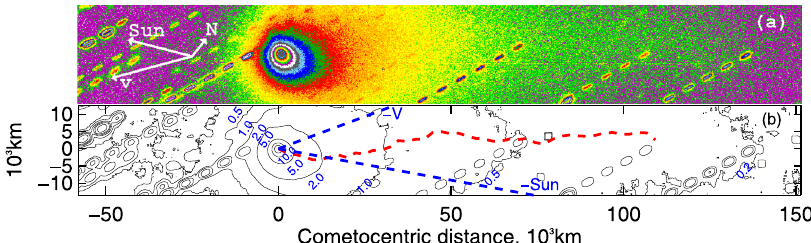
Fig. 3 Imaging of comet 2I/Borisov. Panel a : false colour image of 2I/Borisov; panel b : isophotes in e − s − 1 . Imaging was obtained by stacking all polarimetric frames obtained with the R F fi lter on 15/12/2019. The colours help to highlight the rapid spatial variation of the fl ux; the fl ux distribution may be quantitatively appreciated with the help of the isophotes of panel b (see also panels a and e of Fig. 4). Dust tail is extended for ~3 arcmin approximately along the horizontal direction of the CCD (the 22 ″ wide Wollaston strips of the instruments are oriented 128 ∘ North to East; the direction of the heliocentric velocity vector v is oriented ~143 ∘ and the sunward direction is at ~112 ∘ ). The dashed tracks are due to trailing stars. The red dotted line of panel b traces the comet tail, which at shorter distance from the photocentre is directed along the anti-solar direction, and at larger distances lies in between the anti-solar and anti-velocity direction. Spatial scale of panel a is the same as of panel b